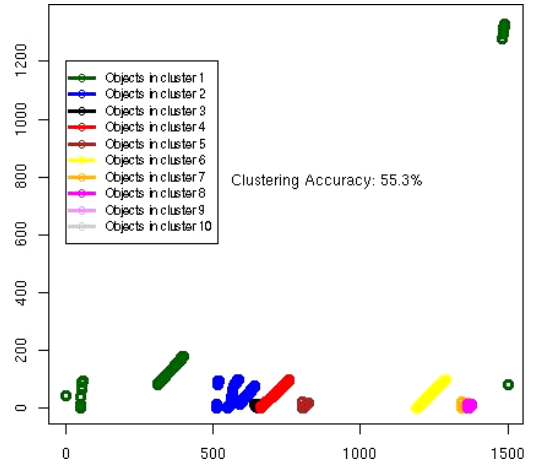
Fig. 5. Size of Clusters by KFCM nt